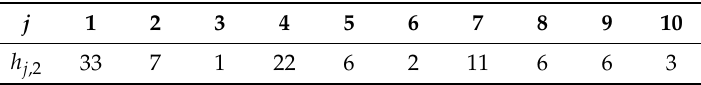
Table 3. The holding cost of components at level 2.